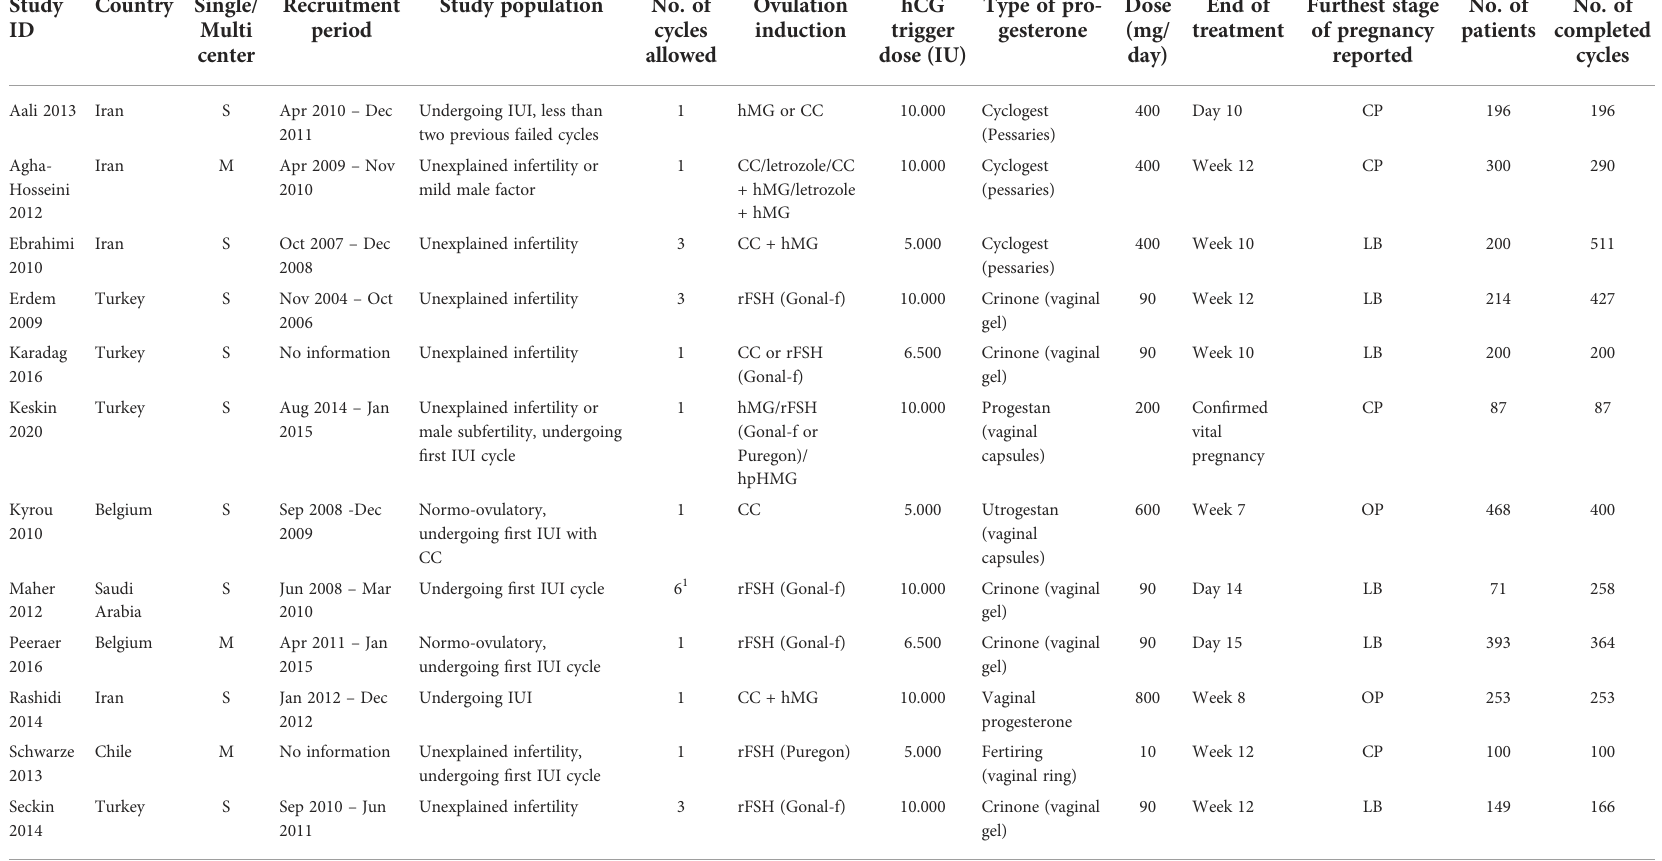
TABLE 1 Characteristics of studies included in